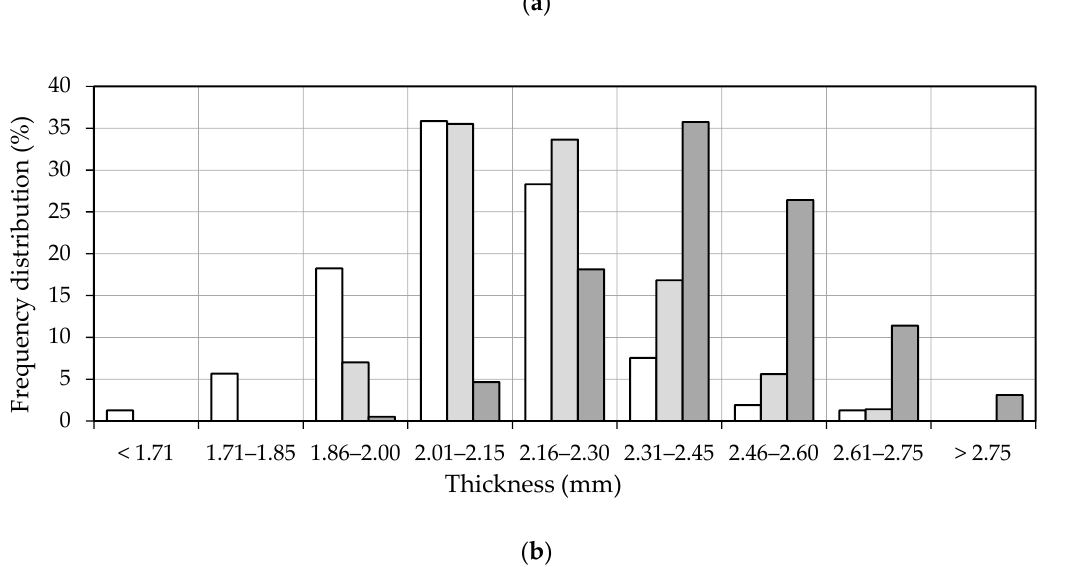
Figure 2. Distribution of mass-weighted terminal velocity ( a ) and thickness ( b ) of black pine seeds.